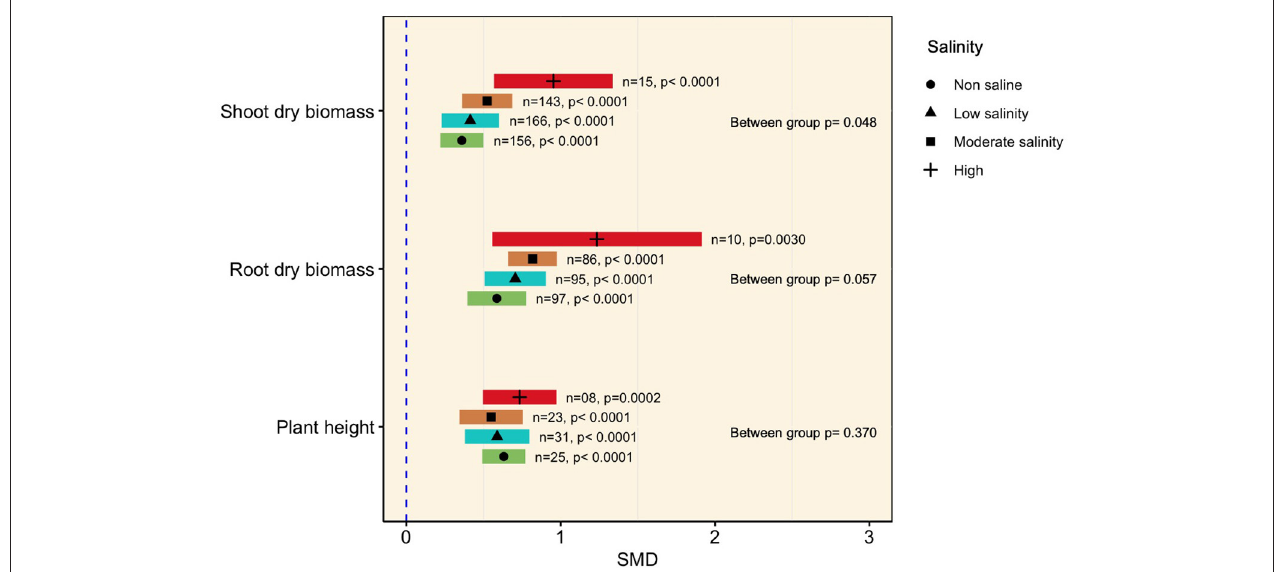
FIGURE 3 | Growth responses of AMF-inoculated plants compared with those of non-inoculated plants under non-stressed conditions and at various levels of salinity. Error bars are effect size (SMD) means 95% CIs. Where the CIs do not overlap the vertical dashed lines, the effect size for a parameter is significant, i.e., the growth ± responses of AMF plants were significantly different from those of non-AMF plants. n , number of studies included in the meta-analysis; p , significance level of SMD.